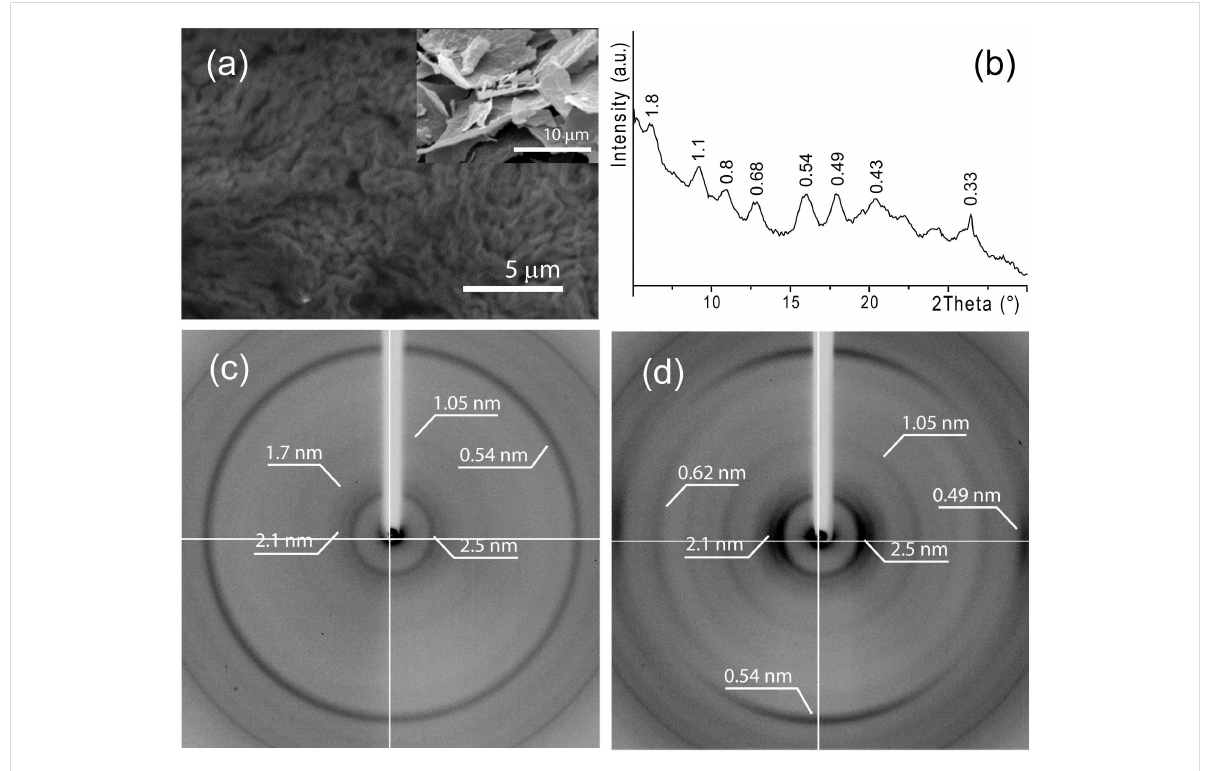
Figure 3: (a) Scanning electron microscopy images of a xerogel 1 film fragment. In the inset a low magnification view of the xerogel film fragments is shown. (b) Powder XRD pattern of a powered sample of xerogel 1 . Low–medium-angle XRD patterns obtained in geometries having the X-ray beam normal (c) and parallel (d) to the surface of a xerogel film fragment.